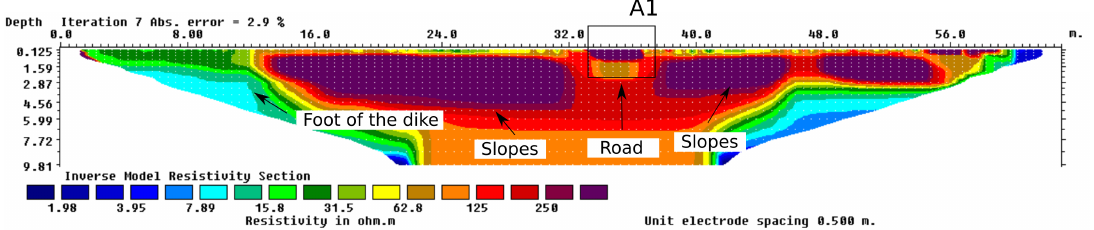
Figure 3. Example of the T10 transverse ERT profile (section IV) displayed without topography. The A1 label refers to the signal associated to the road.